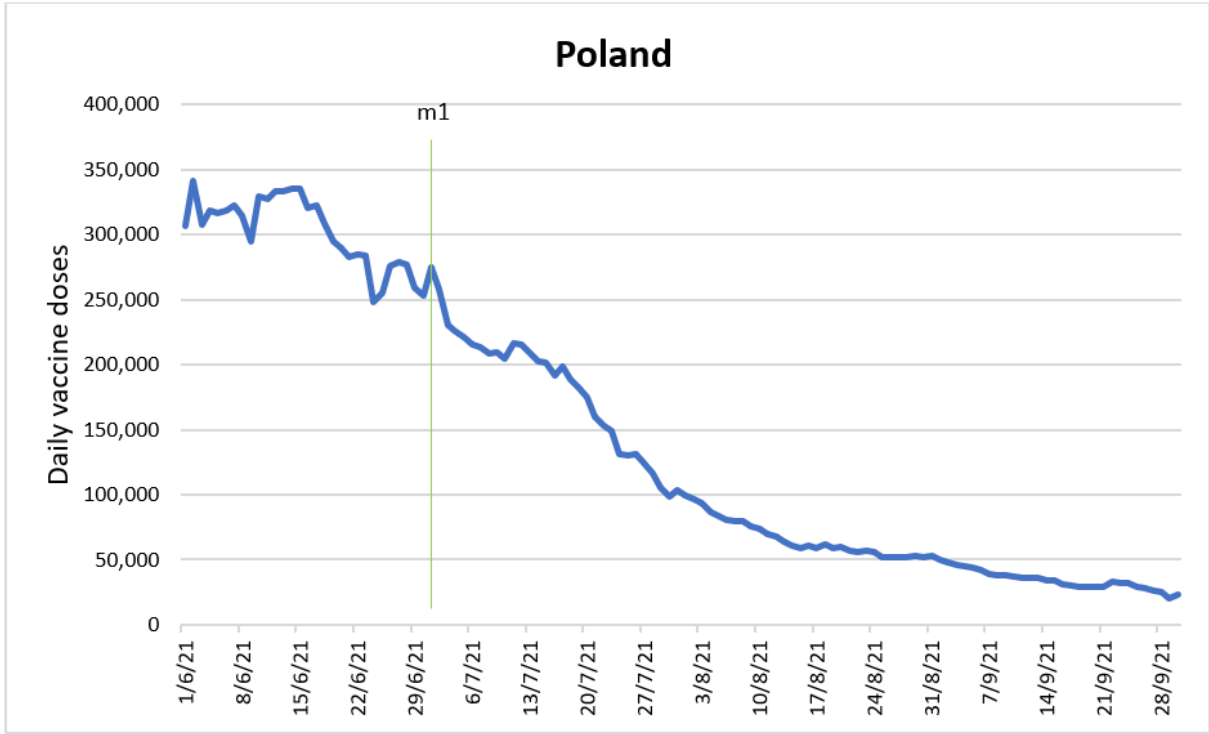
Figure 1. Daily new vaccinations in Austria before and after the policy changes and predicted values Figure 5. Daily new vaccinations in Poland before and after the policy change. Figure 5. Daily new vaccinations in Poland before and after the policy change . in absence of intervention based on ARIMA model. Announcement of employees vaccine Start of Start of national lottery and municipality competitions (m1).